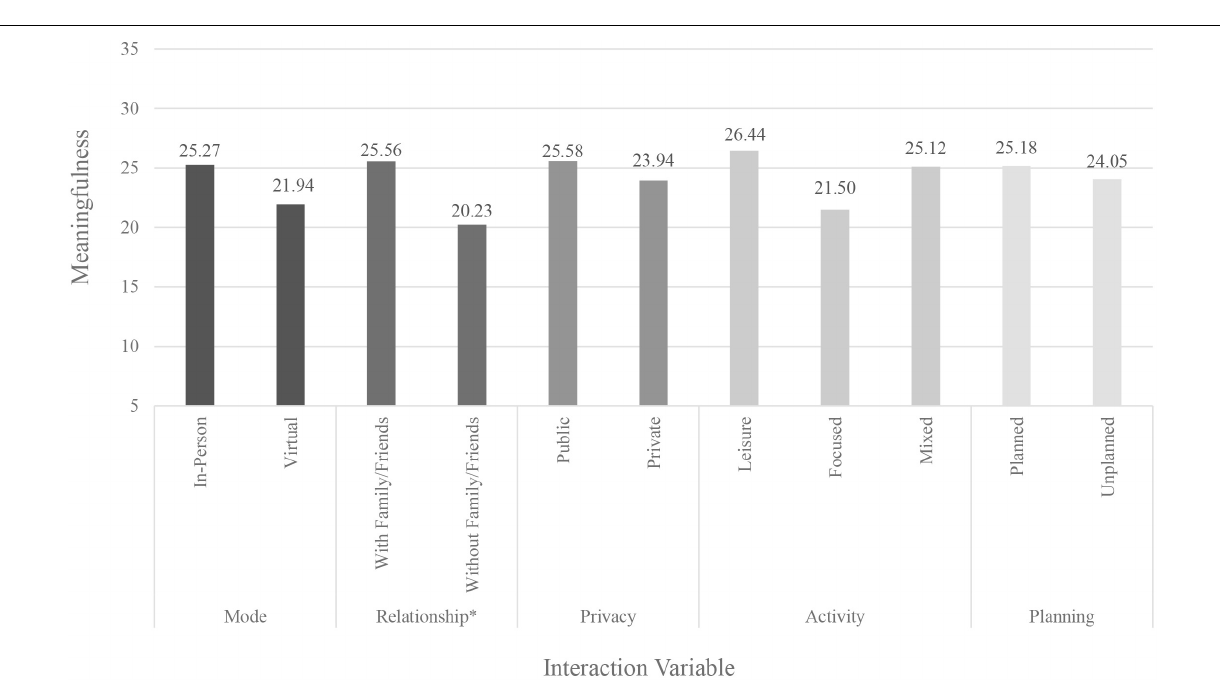
FIGURE 2 | Mean score for loneliness by interaction variable. ∗ Represents p < 0.05 when variable tested